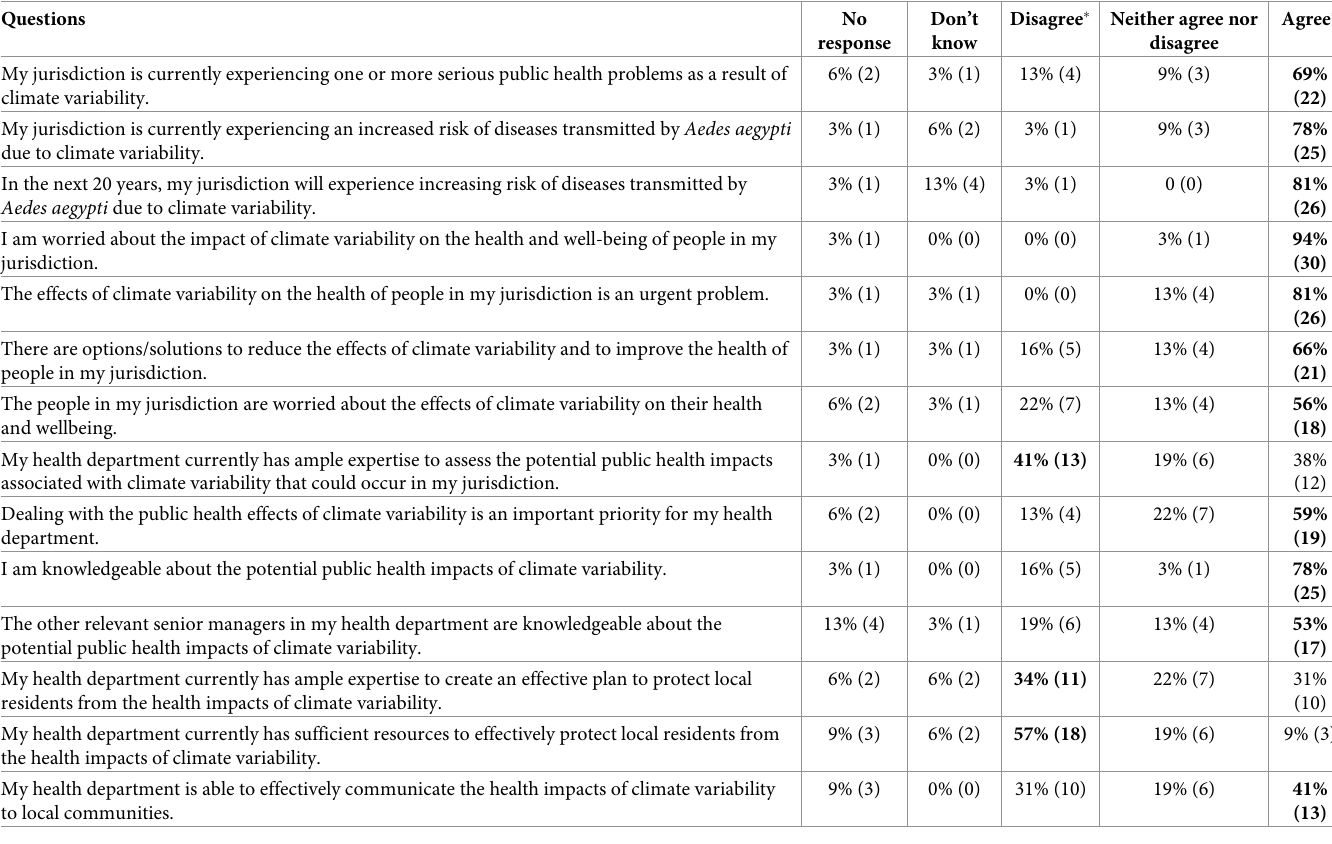
Table 3. Perceptions of climate variability impacts on health reported by survey respondents. Results shown as % (n). This most frequent response per question is highlighted in bold. Adapted from